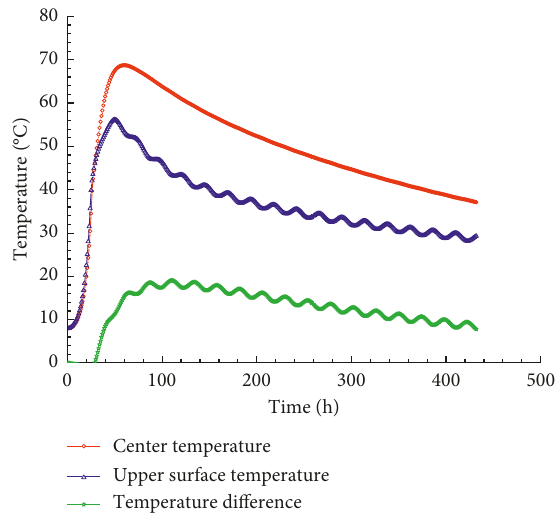
Figure 16: Temperature difference between the core and the upper surface of the 1.65m thick